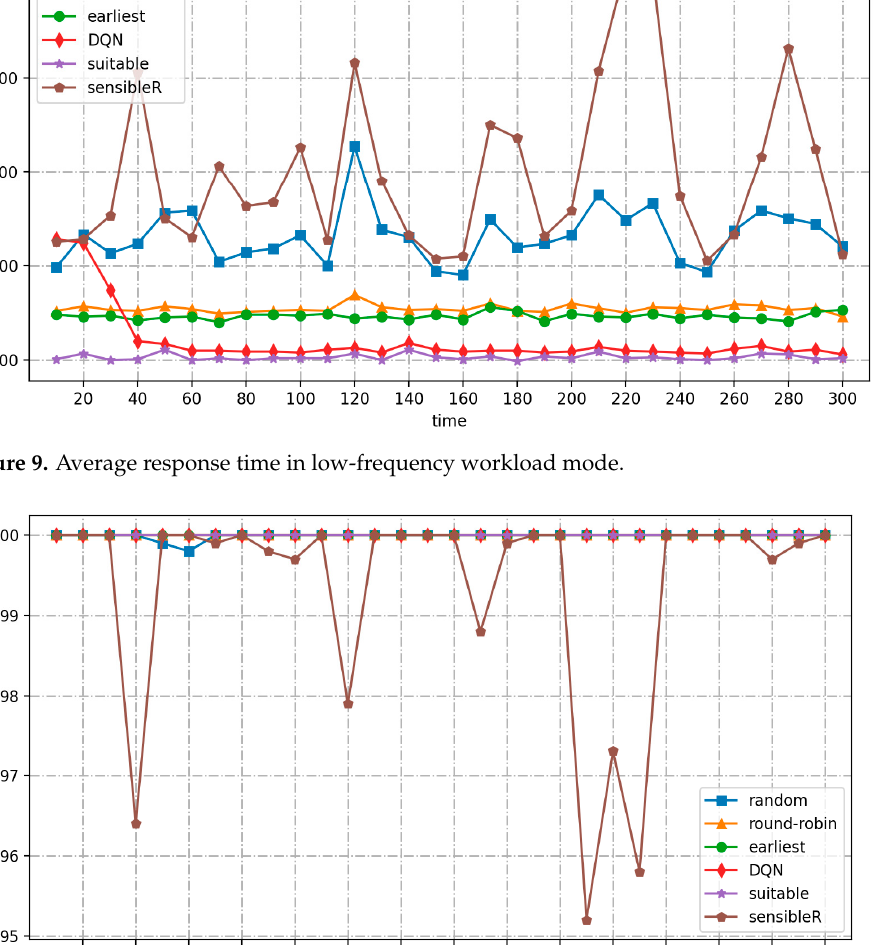
Figure 10. QoS satisfaction in low-frequency workload mode.